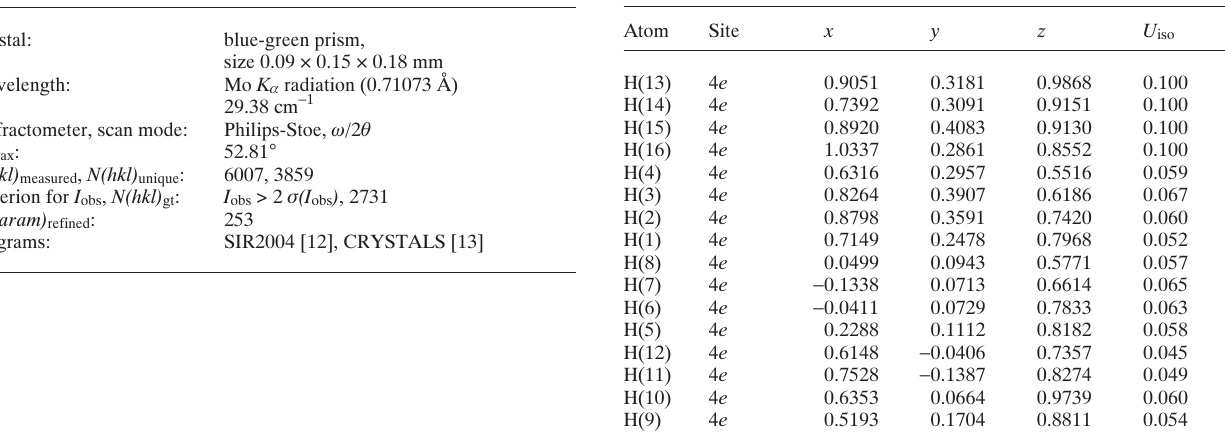
Table 2. Atomic coordinates and displacement parameters (in Å 2 ) . Table 1. Datacollection and